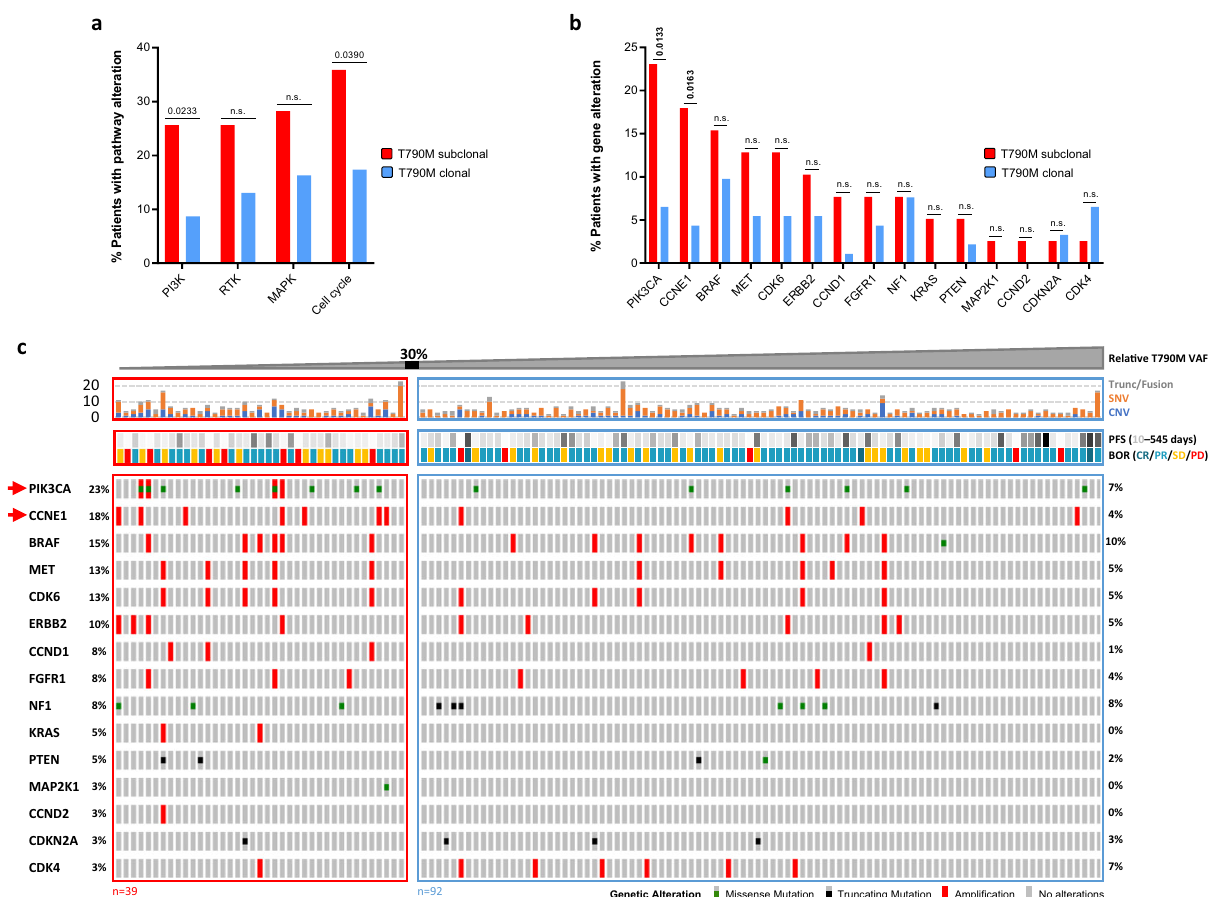
Fig. 3 Genomic co-alterations detected in cfDNA of osimertinib-treated patients in each T790M clonality group. a Percentage of patients with functional alteration in selected pathways known to be involved in TKI resistance (list of pathway members included in the sequencing panel in Supplementary Table 4). Two-sided Fisher ’ s exact test was performed to detect statistically signi fi cant differences between the T790M subclonal (red, n = 39 patients) and clonal (blue, n = 92 patients) subgroups. N.s. not signi fi cant. b Percentage of patients with functional alteration(s) in selected genes in T790M subclonal (red) versus clonal (blue) subgroup. P value determined using the two-sided Fisher ’ s exact test. N.s. not signi fi cant. c Oncoprint of co- occurring mutation events in baseline plasmas and clinical response in osimertinib-treated patients with T790M clonality value ( n = 131). Patients were sorted according to their relative T790M VAF value, the 30% subclonality threshold is marked. Only EGFR alterations and known pathogenic aberrations in genes known to be involved in TKI resistance are shown in the oncoprint. The top panel shows the number of all non-synonymous genetic aberrations (in all 73 tested genes) detected in each baseline plasma sample. Red arrows indicate genes signi fi cantly more frequently mutated in the T790M subclonal group. CNV events reported by Guardant Health for a copy number value >2. Trunc/Fusion truncating/fusion variants, SNV single-nucleotide variants, CNV copy number variants, PFS progression-free survival, BOR best objective response (assessed according to RECIST criteria), CR complete response, PR partial response, SD stable disease, PD progressive disease. Full list of gene alterations presented in the oncoprint is shown in Supplementary Table